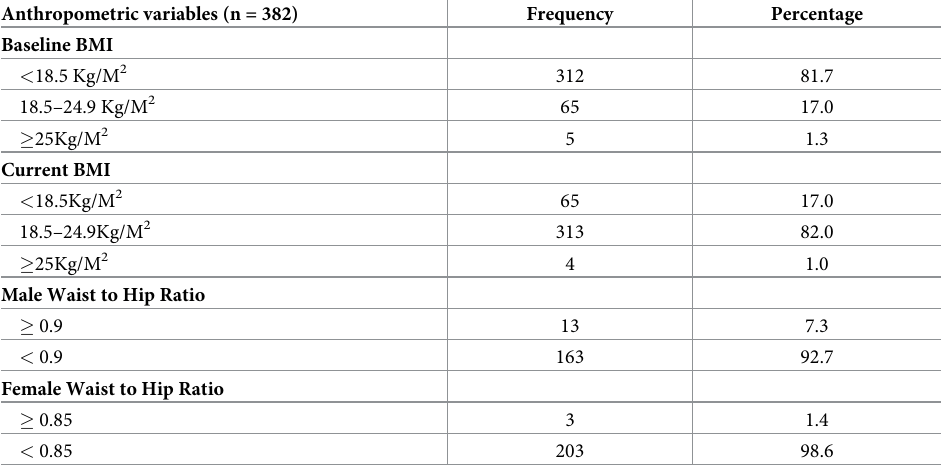
Table 3. Anthropometric related characteristics of respondents receiving HAART at NEMMRH, Southern Ethio- pia, and January 20-March 20, 2020. Anthropometric variables (n = 382)